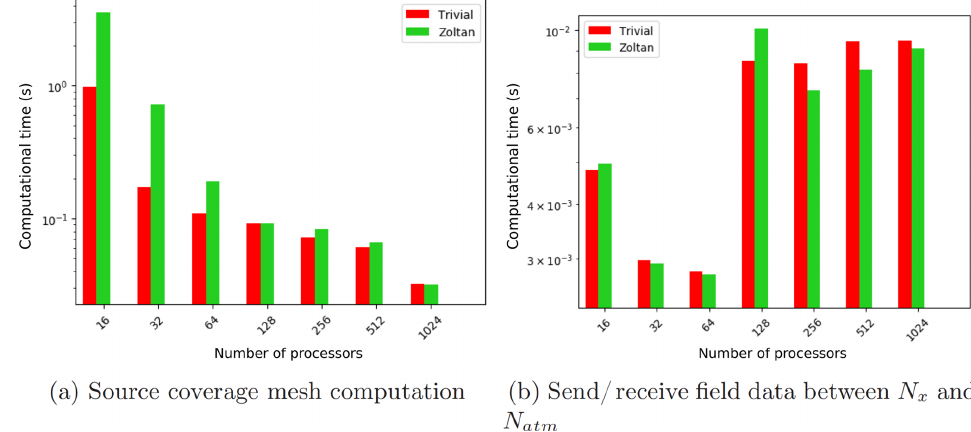
Figure 13. Scaling of the communication kernels driven with the parallel graph computed with a trivial redistribution and the Zoltan geo- metric (RCB) repartitioner for the NE120 case with N ocn = N x and N atm = N x / 2 on Cori.